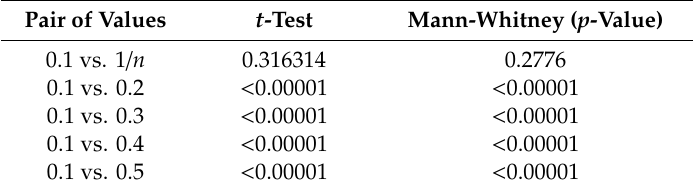
Table 8. Statistical comparison between the 0.1 mutation probability and the others.